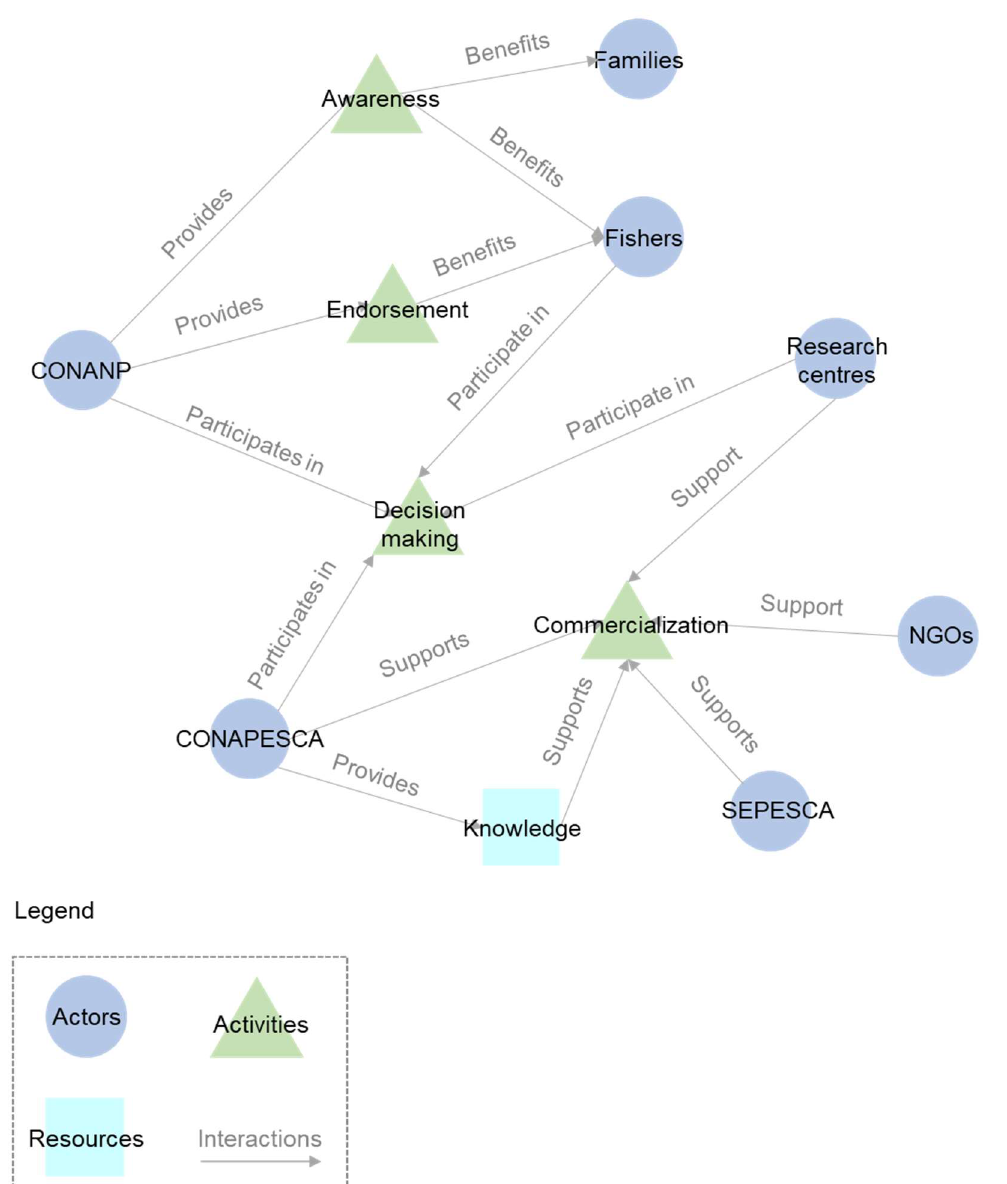
Fig. A3.6. Individual mental model of a research centre’s